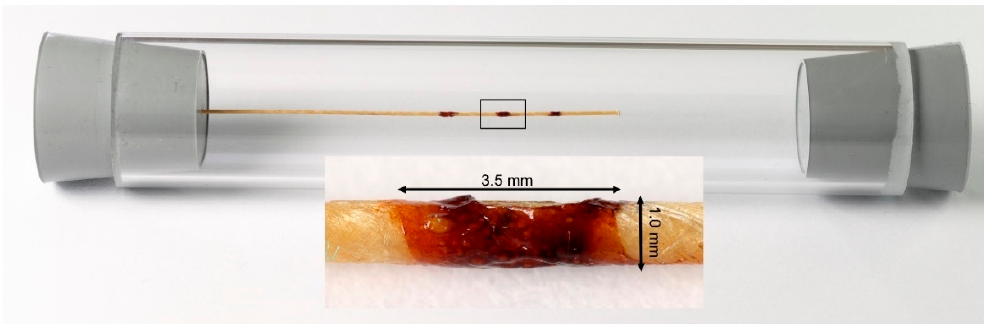
Figure 3. The nonmagnetic guidewire with three discrete markers (distance 10 mm) centrally aligned in an acrylic glass container. The markers contain both KLB and Bayoxide 8706 particles. For the MRI images, the container was filled with diluted gadolinium-based contrast agent. The magnified image of the middle marker illustrates the uneven surface of the coating.